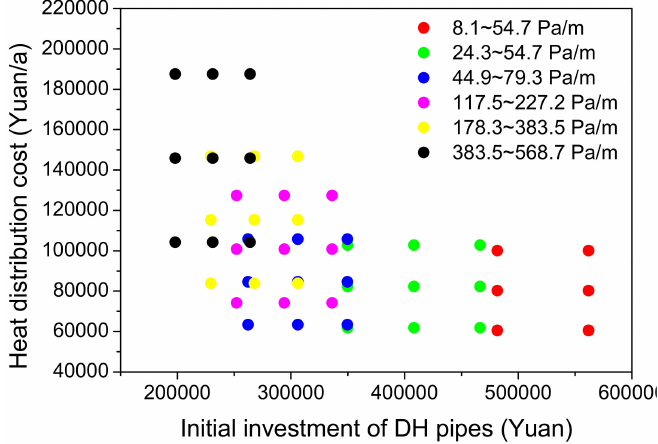
Figure 5. Optimization results for the heat distribution cost and initial investment in the sample DH